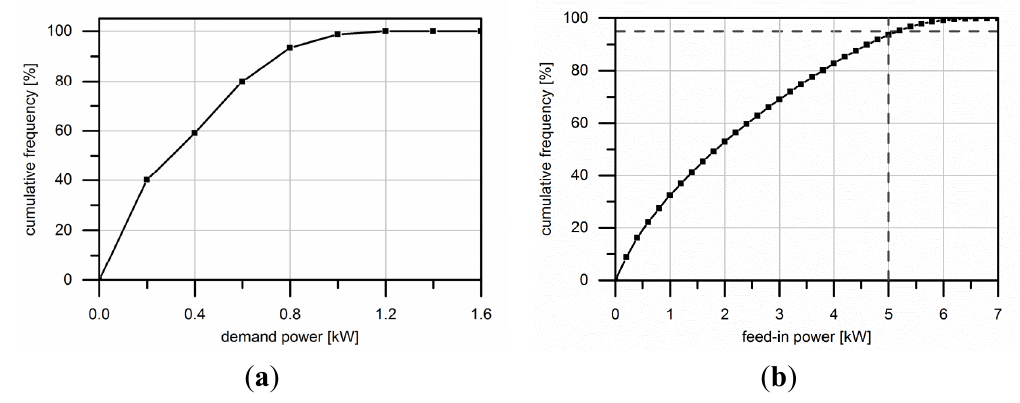
Figure 4. ( a ) Cumulative frequency distribution of demand power; ( b ) Cumulative frequency distribution of feed-in